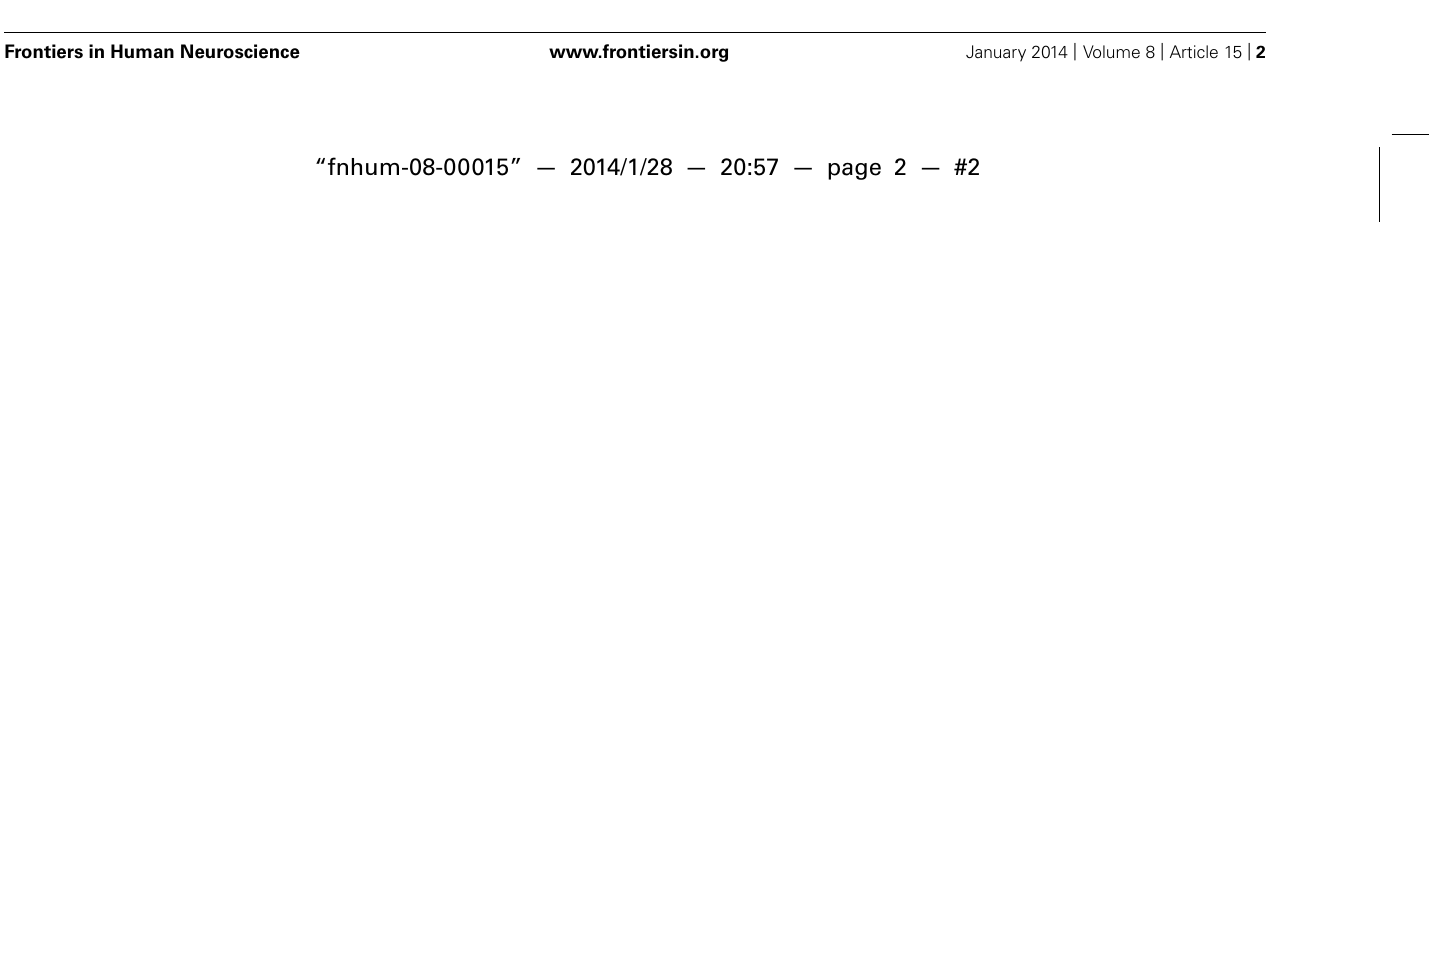
presented as a picture and on the other half it is presented as a set of words that name equivalent features. Likewise, the probes are presented as words on half of the trials and as pictures on the other